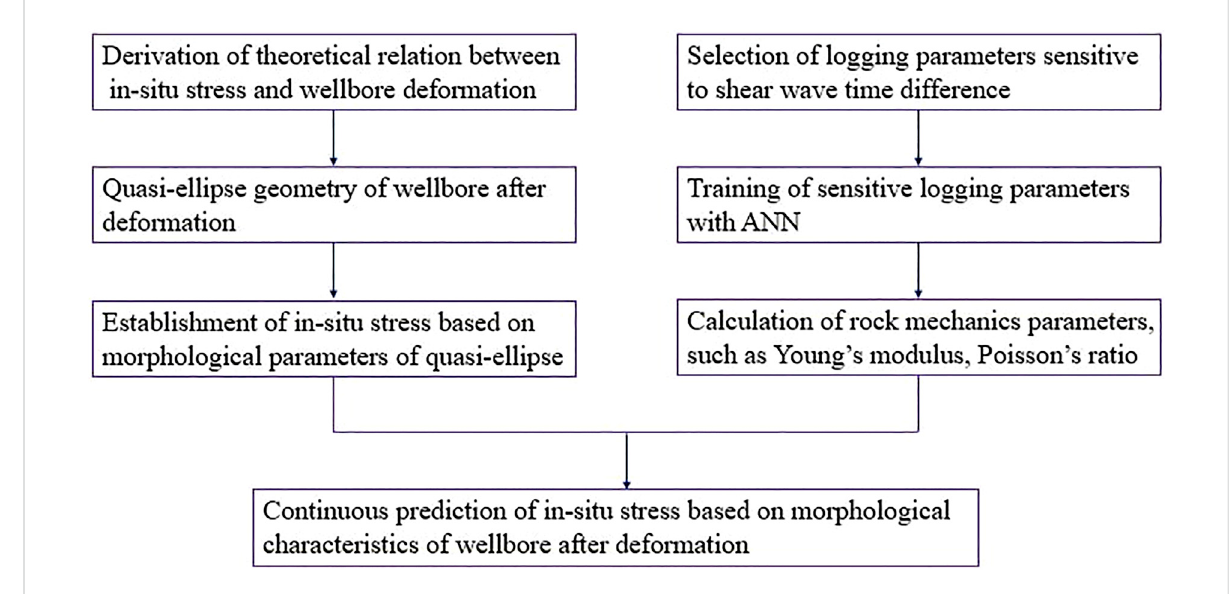
FIGURE 1 Continuous in situ stress prediction fl ow chart based on borehole deformation